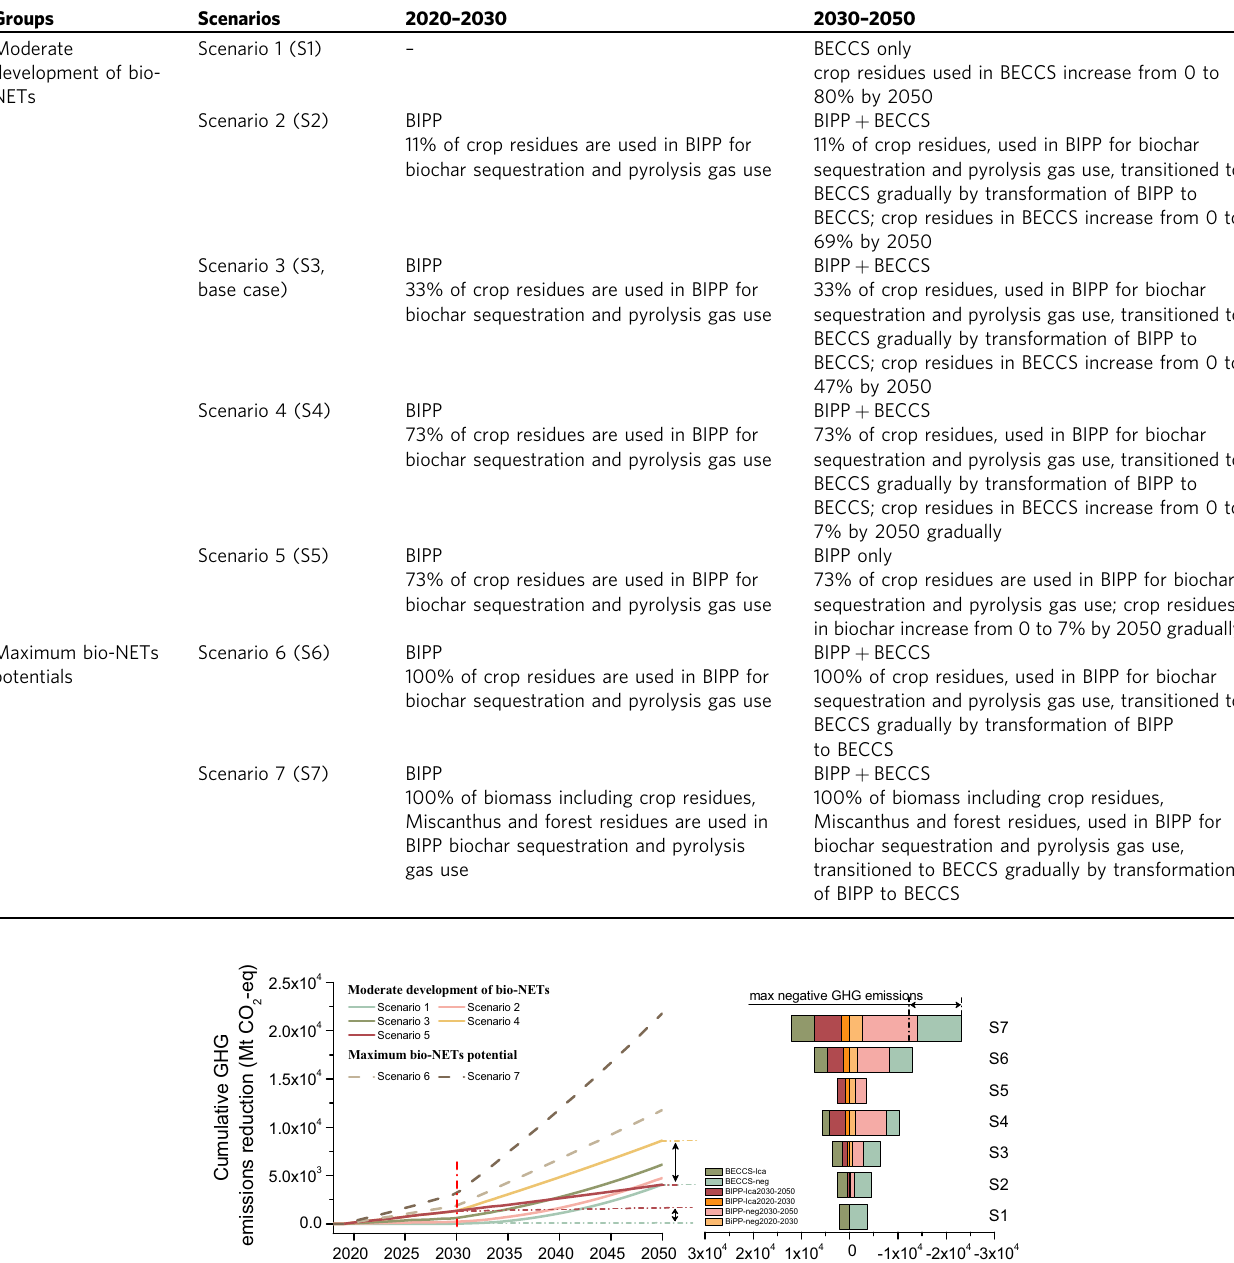
Table 2 Annual China ’ s available biomass feedstock allocation (explained in Supplementary Note 17) for bio-NETs (BIPP and/or BECCS) during 2020 – 2050.